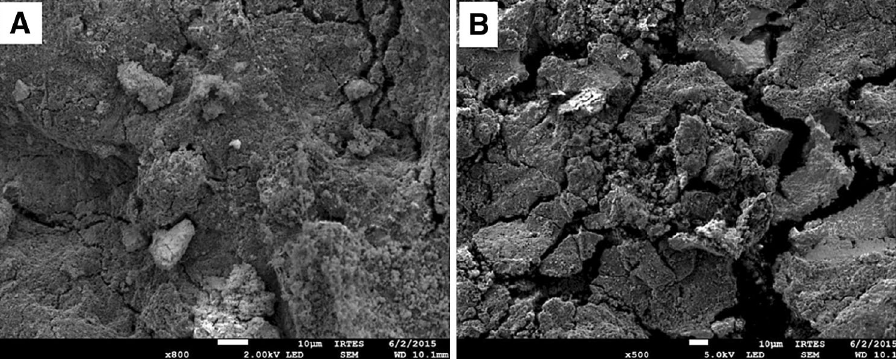
Fig. 7 SEM micrograph of a LaGaO 3 electrode surface: a as- prepared electrode and b after 20th cycles. Reprinted from Ceramics International